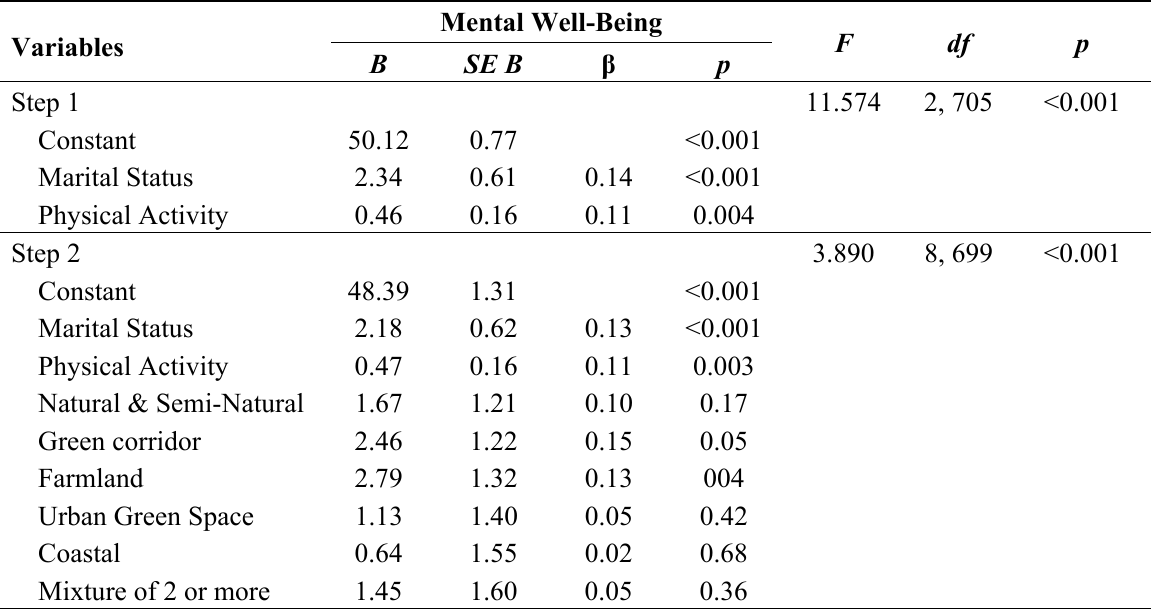
Table 5. Hierarchical regression analyses for variables predicting mental well-being of frequent group walkers attending at least once a week ( n =